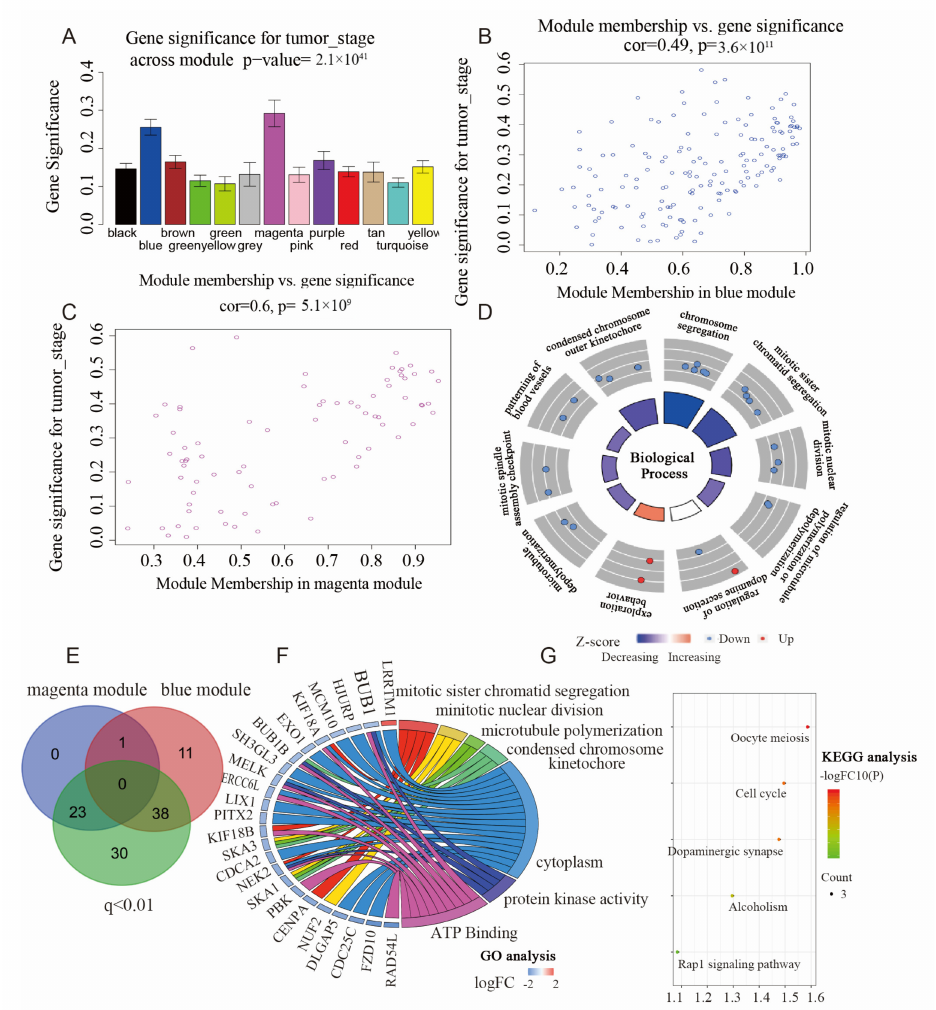
Figure 5. Functional annotation of hub genes. ( A ) GS for tumor stage across each module. ( B ) The plot of GS for tumor stage with MM in blue modules. ( C ) The plot of GS for tumor stage with MM in magenta modules. ( D ) In the genes of blue and magenta modules represented (Table S5), bubble plot of top 10 biological process by GO enrichment analysis. ( E ) Venn plot of 61 screened hub genes (blue and magenta modules: GS > 0.2, MM > 0.8, and q < 0.01). ( F ) In 61 screened hub genes, GO chord plot demonstrated the top 7 GO enrichment analysis and 24 featured genes. ( G ) In 61 screened hub genes, bubble diagram of pathway enrichment